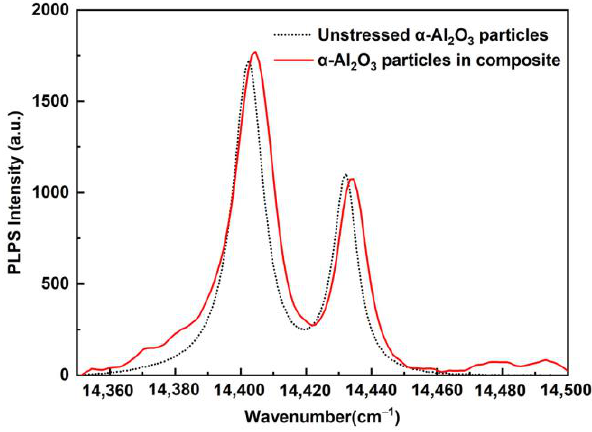
Figure 11. Typical PLPS spectra of Cr 3+ R 1 and R 2 peaks from unstressed α -Al 2 O 3 particles and the α -Al 2 O 3 particles in C f /SiC-Al 2 O 3 composite.